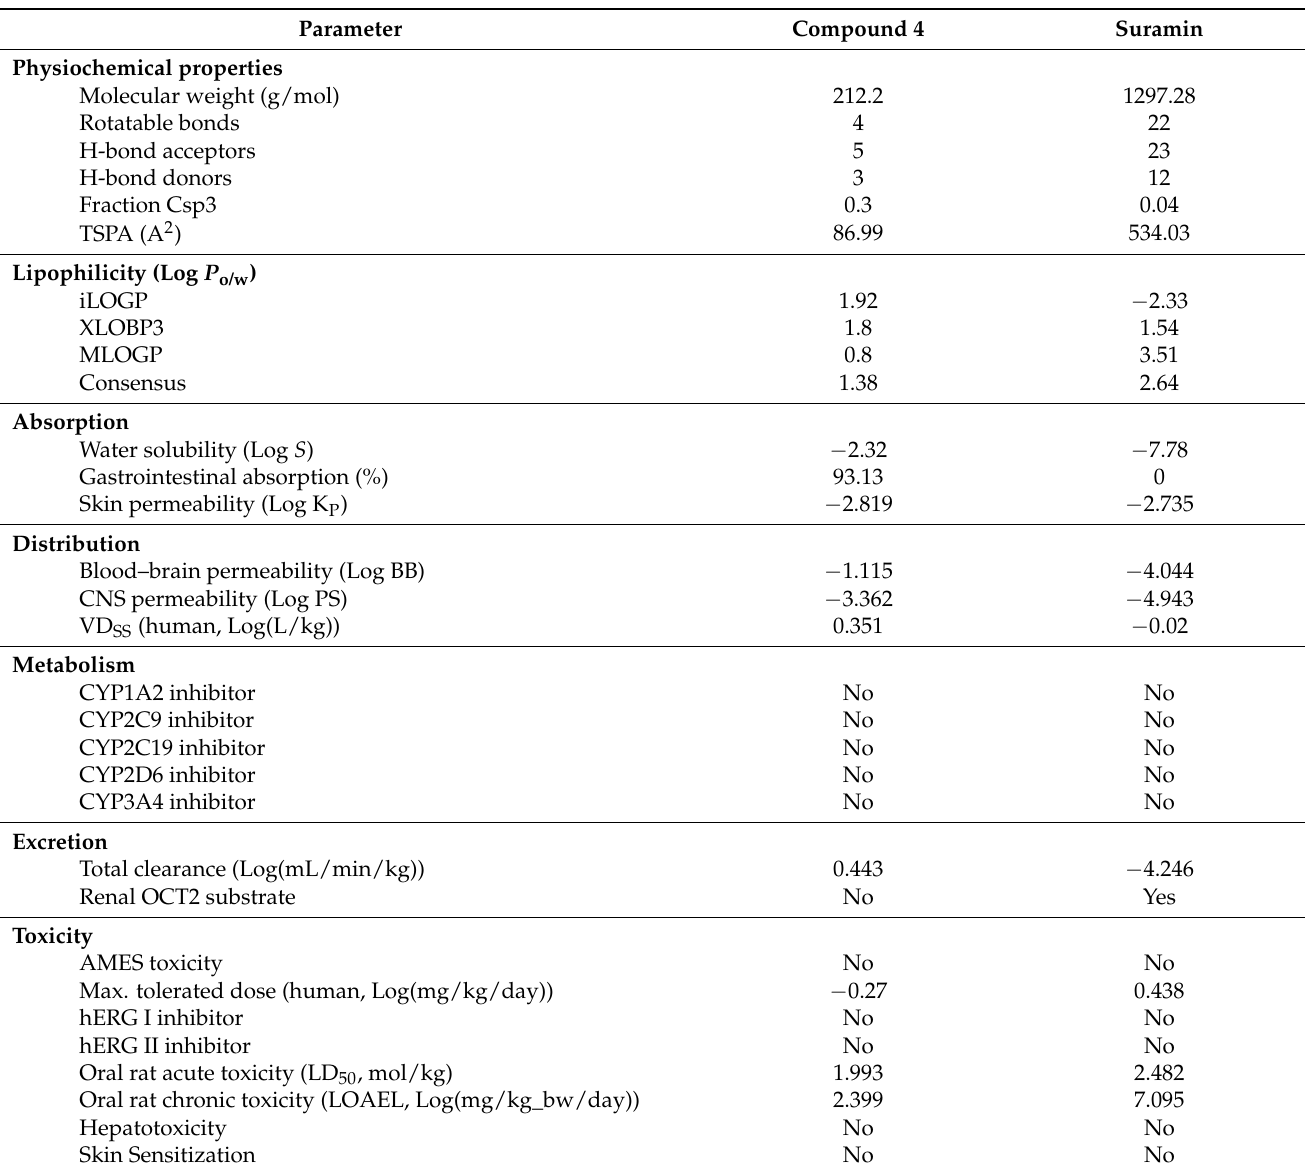
Table 5. ADMET predictions for compound 4 and the reference drug